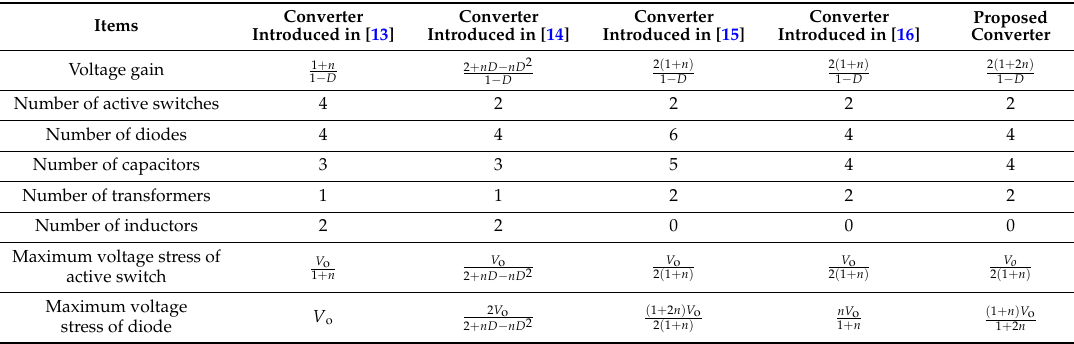
Table 1. Comparison among the proposed and other high step-up